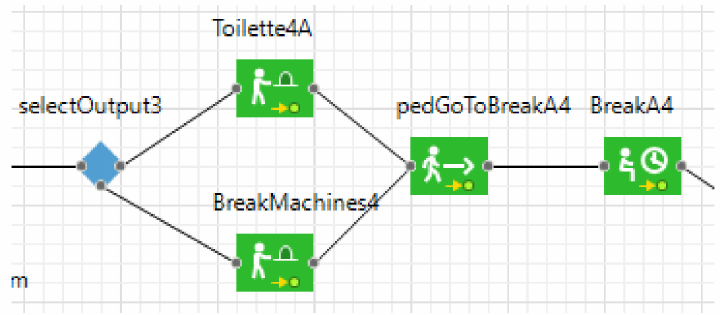
Figure 8. Break time